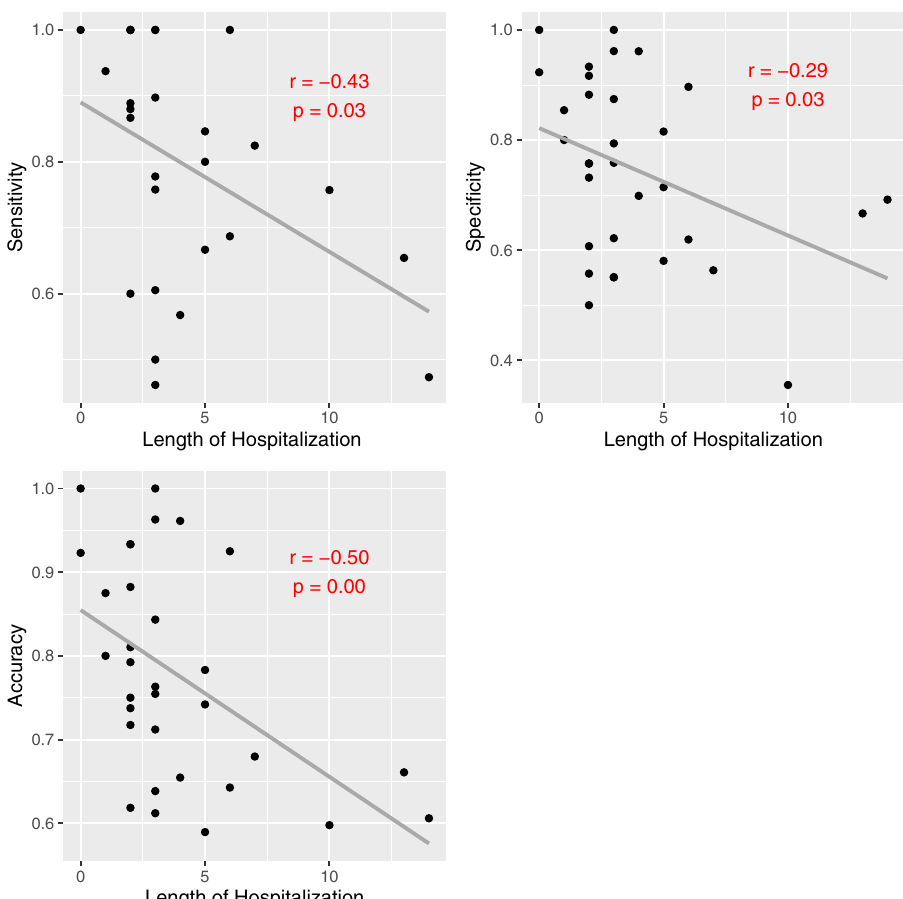
Fig. 6 Model metrics vs. duration of hospitalization. R and P values based on Pearson